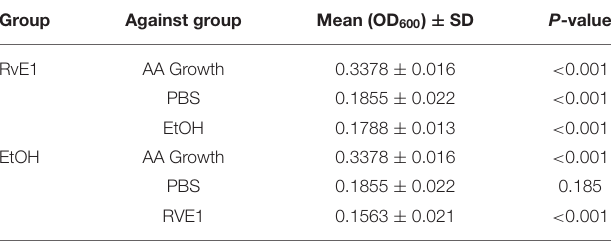
TABLE 1 | Comparisons of group mean optical density (OD 600 ) ± standard deviation. Group